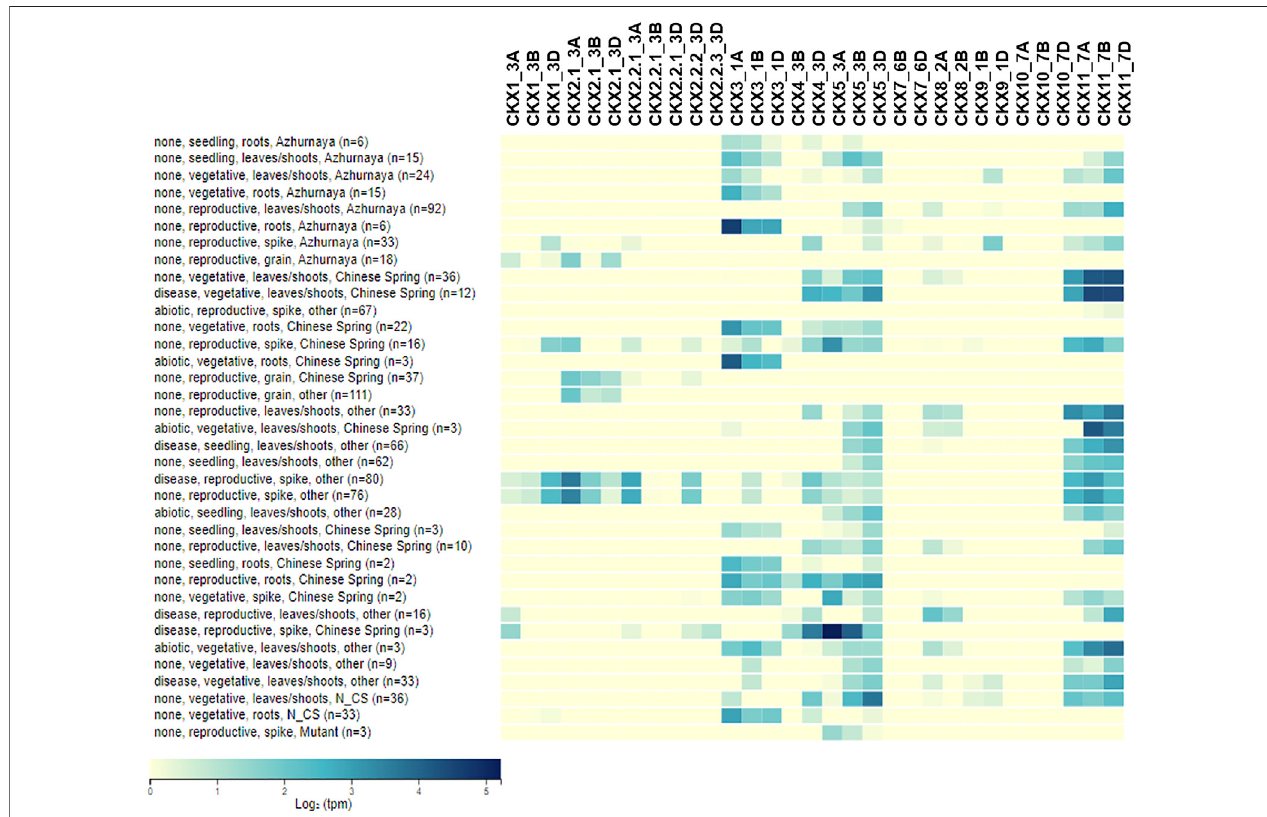
FIGURE 7 | Heatmap for gene expression trend of CKX gene family in different tissue and stages of Triticum aestivum .